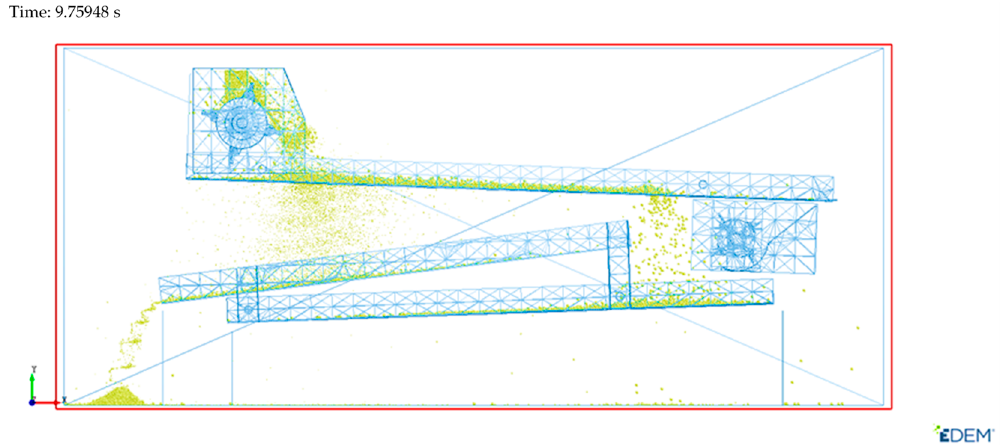
Figure 17. Simulation of the tuber picking and screening process.